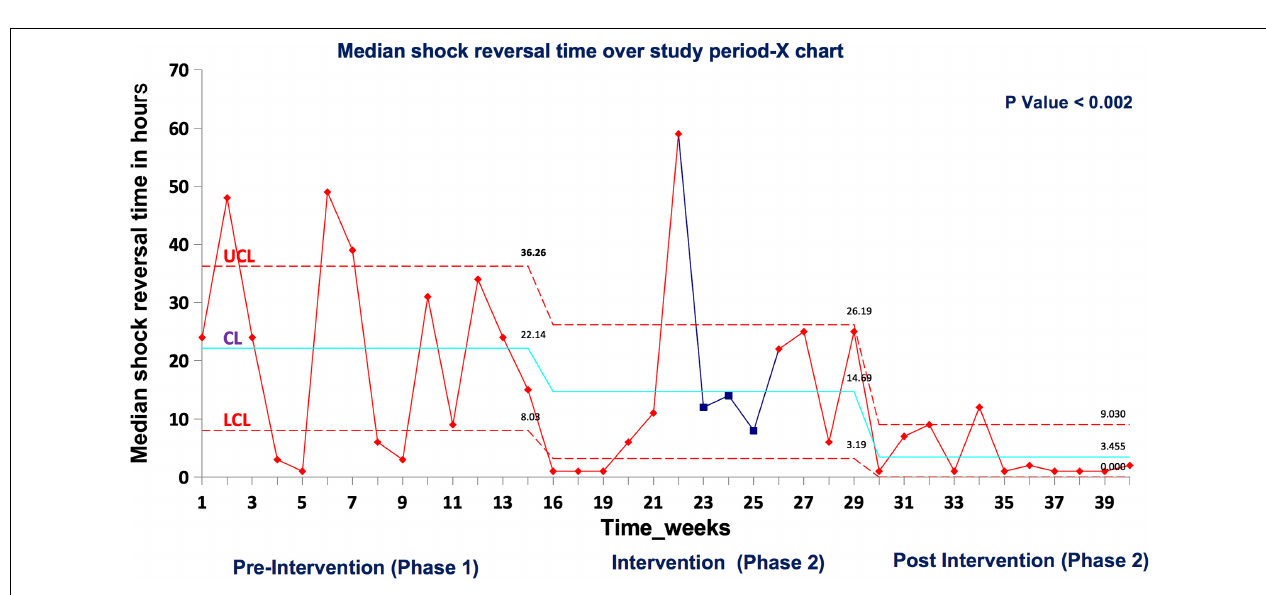
FIGURE 11 | Median shock reversal time in real patient events UCL, upper control limit; CL, center line; LCL, lower control limit.